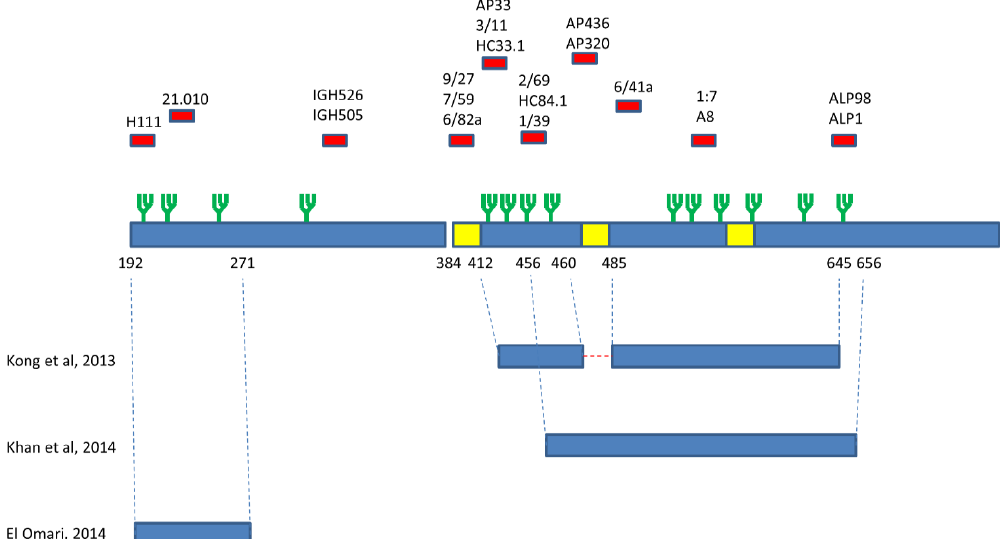
Figure 5. Cartoon of the protein constructs used for crystallization of E1 (71) and E2 [42,49] mapped onto the HCV E1 and E2 genes (blue). Regions possessing antibody epitopes are highlighted in red; glycosylation sites are indicated by a green branching structure; and hypervariable regions are highlighted in yellow. The numbering of the ends of the protein constructs are highlighted. A red dashed line represents a Gly-Ser-Ser-Gly linker added between two regions in the E2 core construct reported by Kong et al. , 2013 [42].